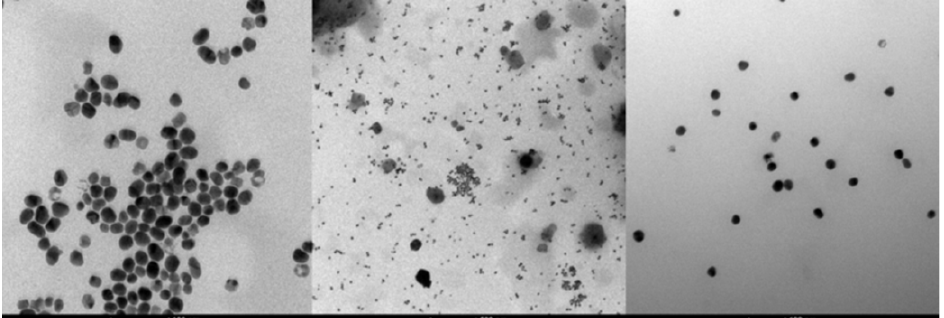
Figure 4. TEM image of Au − Ag hybrid nanofluid.